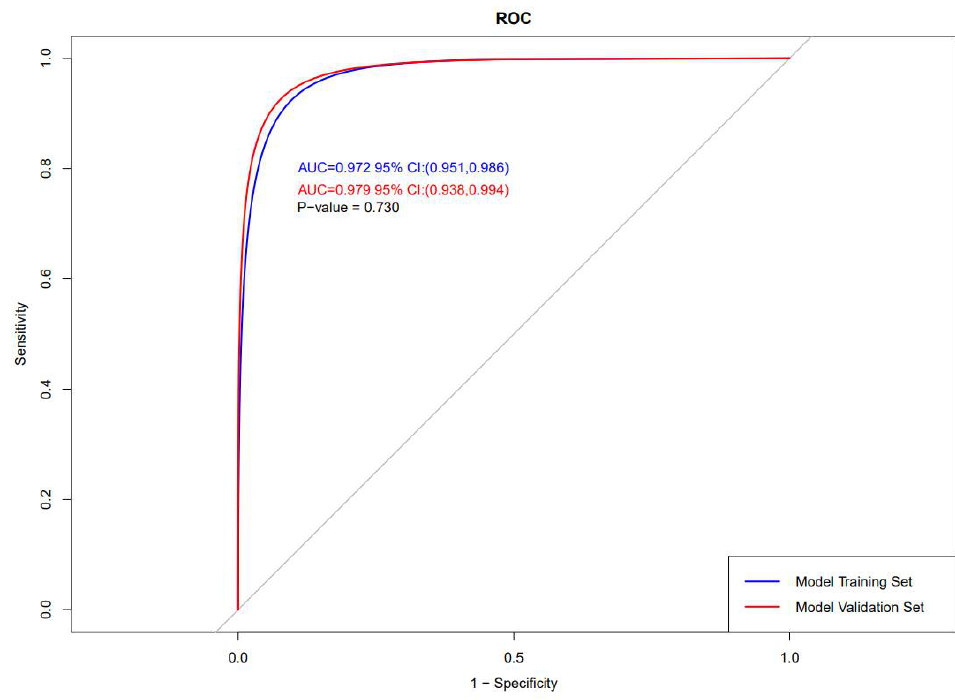
Figure 5. Plot for the ROC curves.